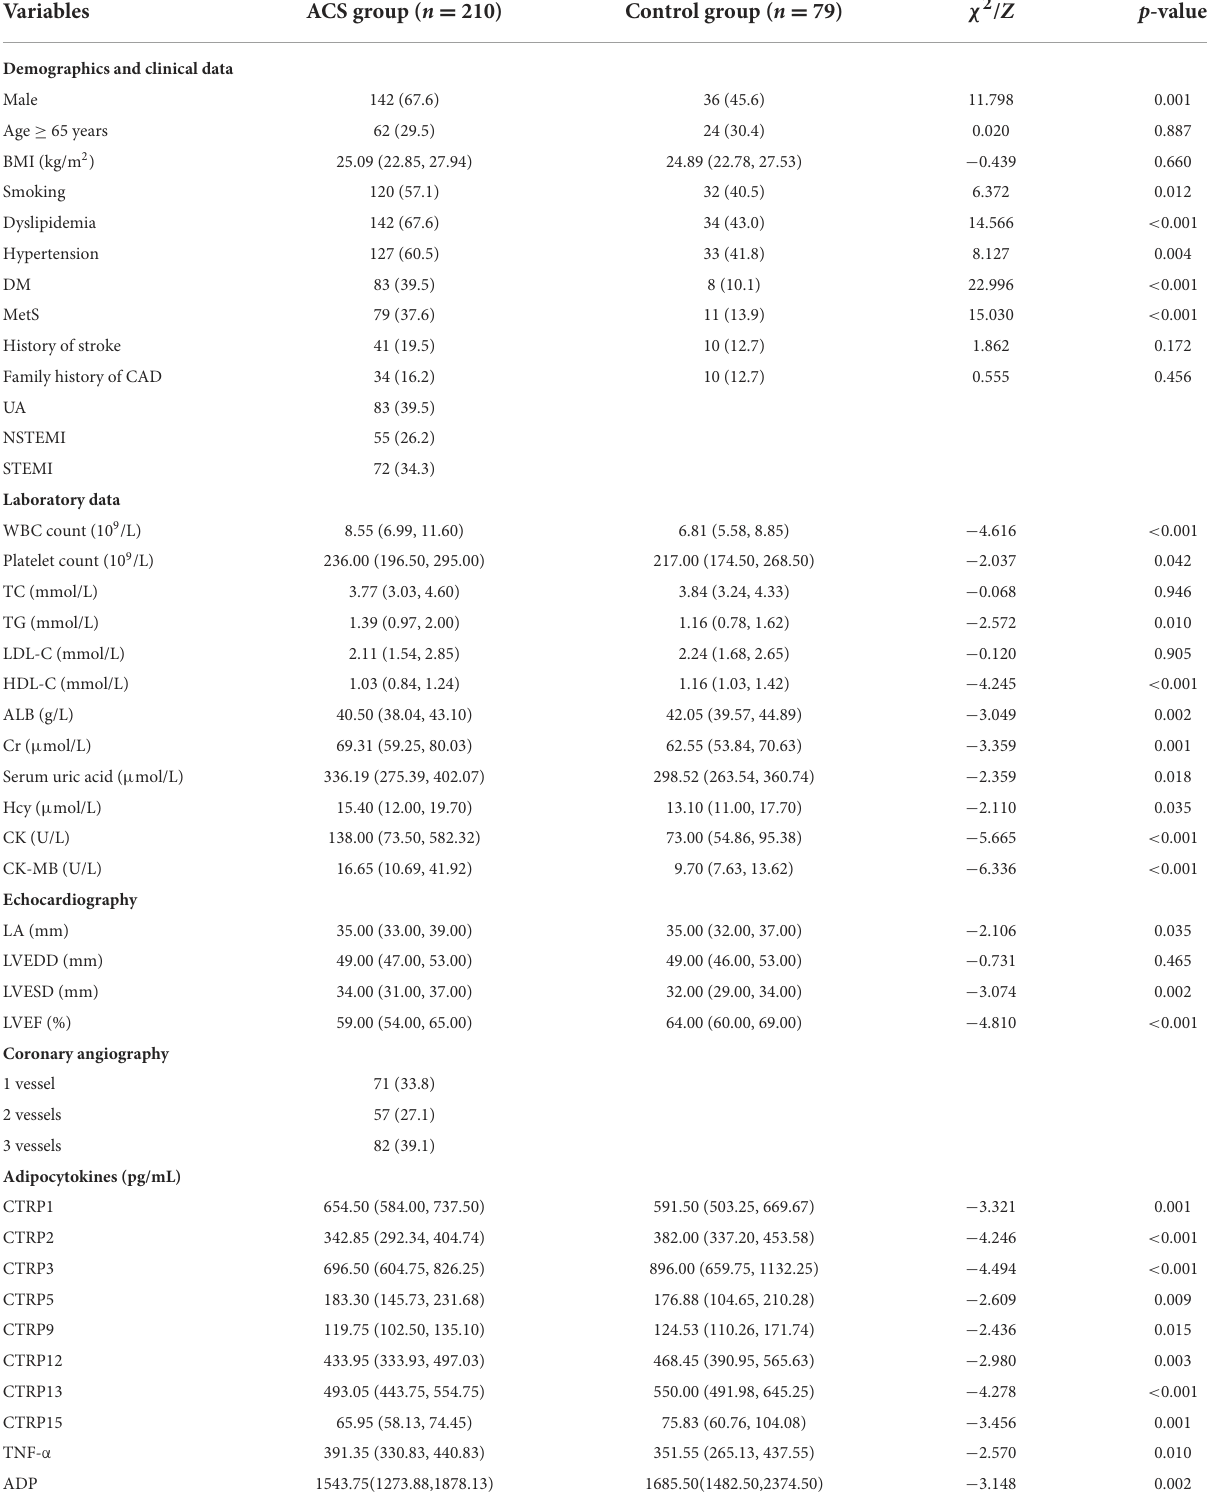
TABLE 1 Baseline clinical characteristics of ACS and control